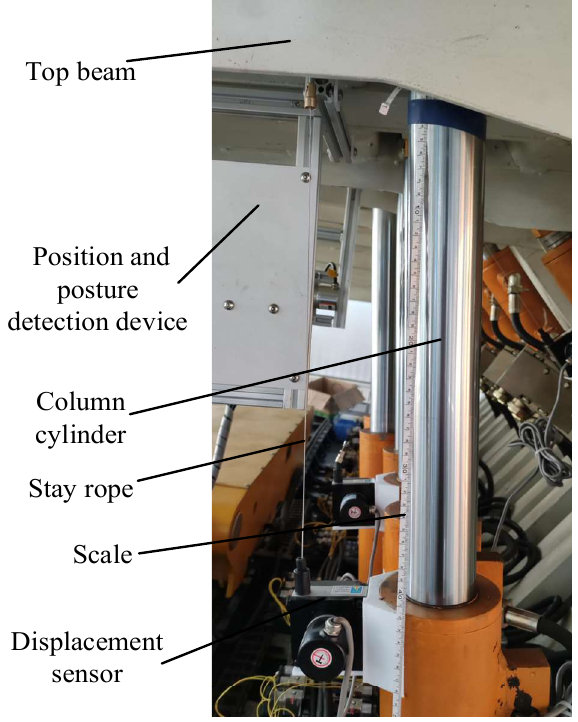
Figure 10. Sample collection experiment of column cylinder.